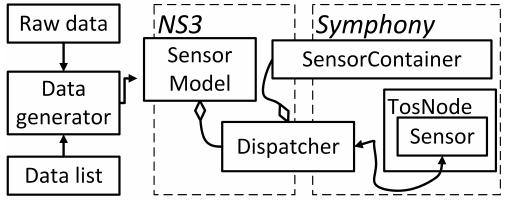
Figure 4. The architecture of the Data Feedscope that supports the sensor